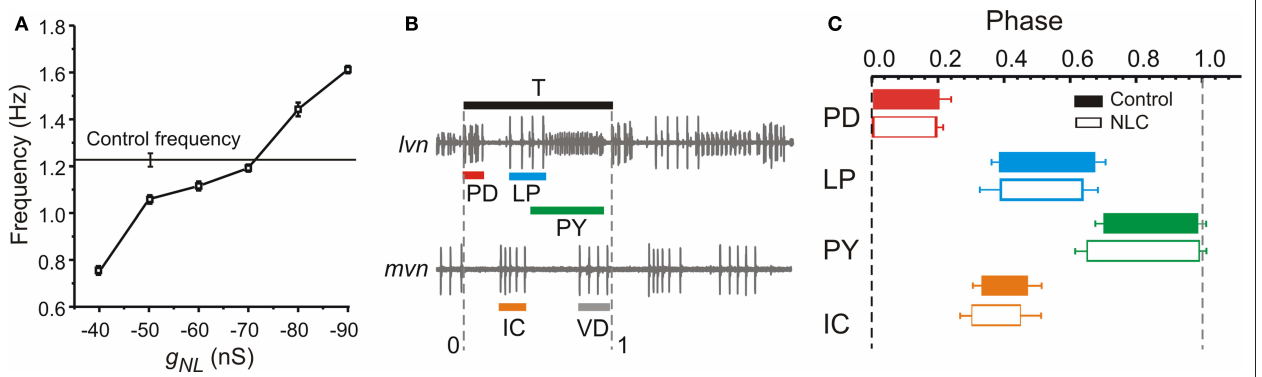
bars show duration of each neuron’s firing phase. Vertical dashed lines indicate mark the beginning and end of the cycle divided by T. (C) Phase diagram of pyloric activity. Each neuron’s spiking time is represented as a fraction of T ( ± SD). PD neuron firing is used as reference and thus begins at phase = 0. Filled bars are control conditions; open bars are in response to negative leak current injected with dynamic clamp ( g = − 80 nS). ( N = 6; N = 2 for the IC neuron which is not active in all preparations). NL